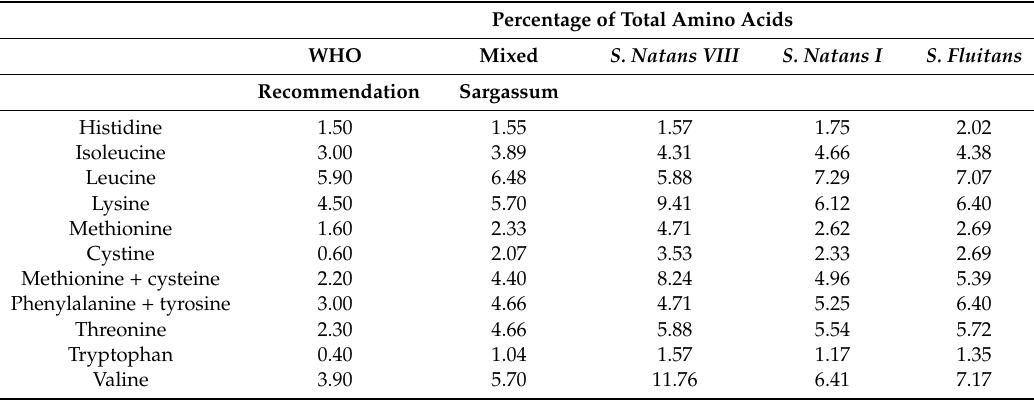
Table 12. ‘Indispensable amino acids’ as a percentage of total amino acids. Recommendation of